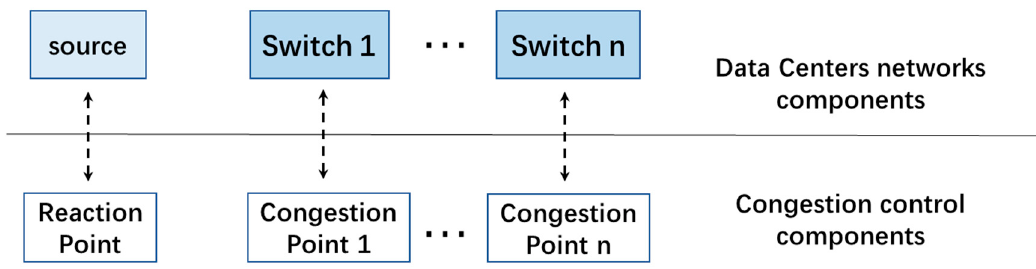
Figure 2. Architecture of P4QCN algorithm.